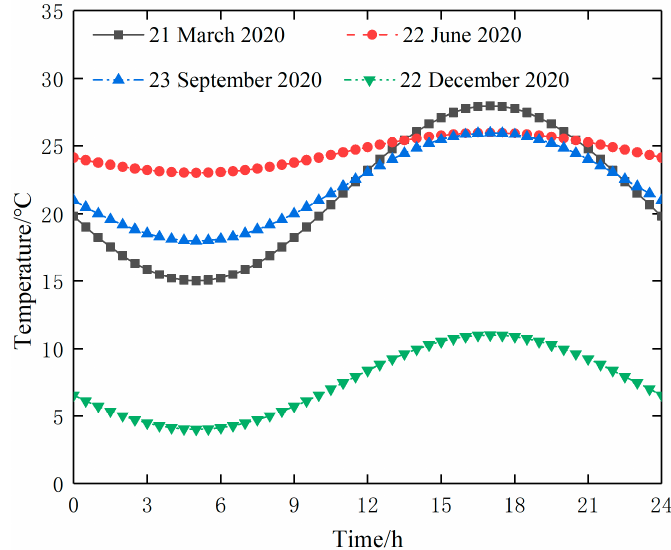
Figure 7. Typical Temperature in four seasons.